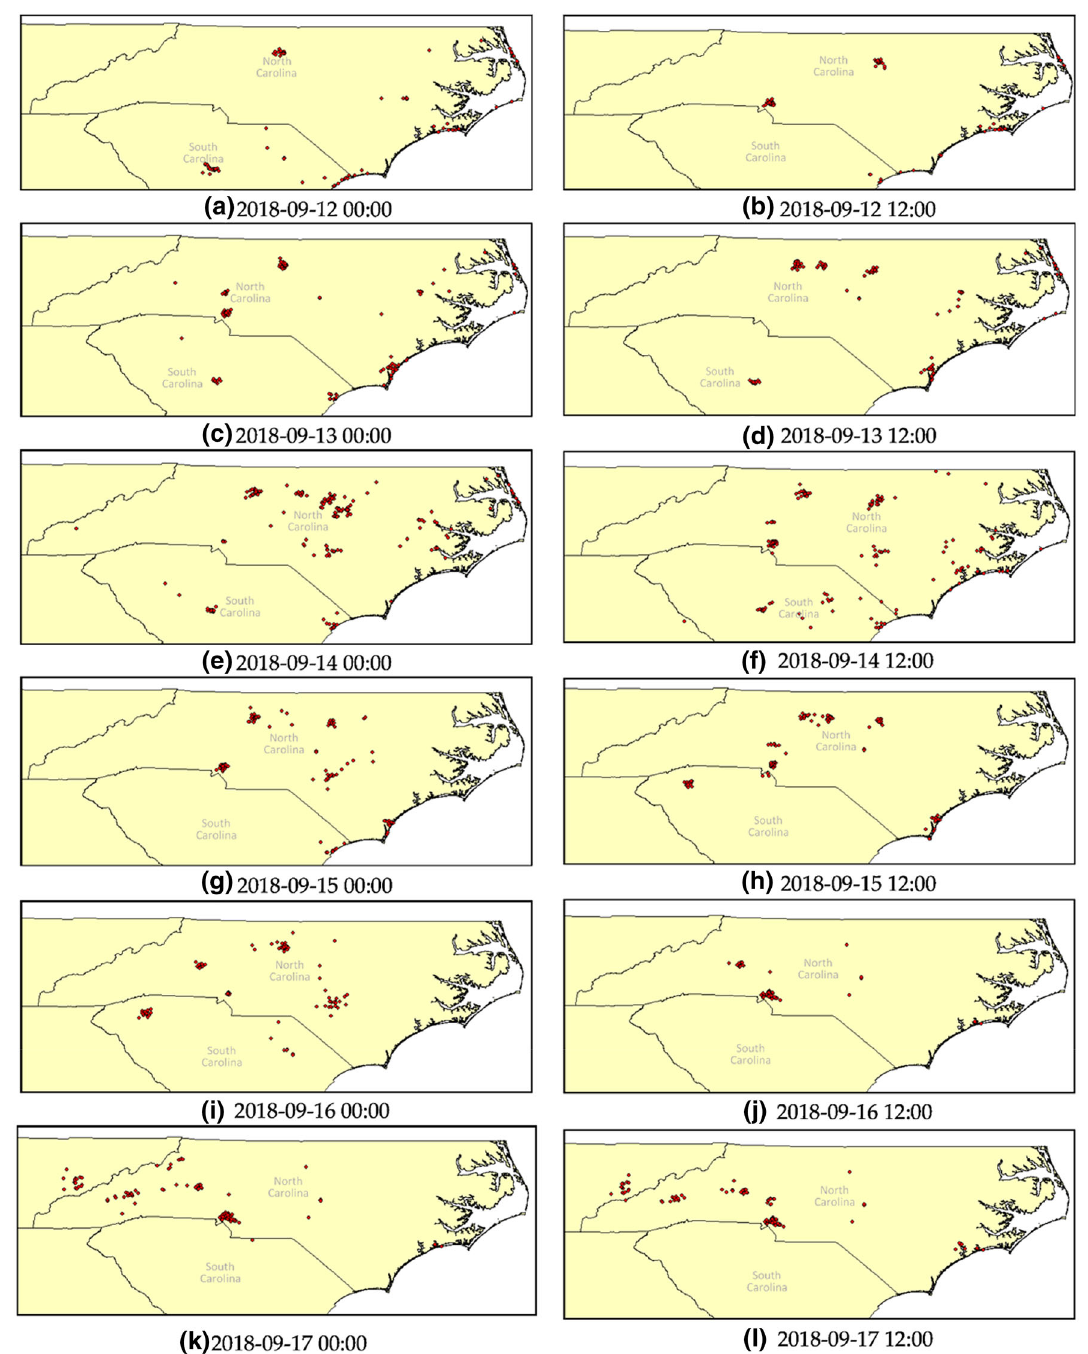
Fig. 3 Spatiotemporal distribution of tweet clusters related to Hurricane Florence in North and South